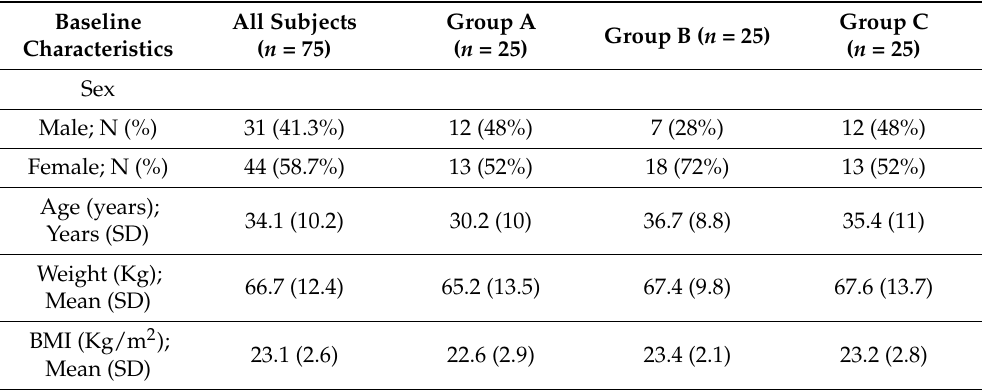
Table 1. Subjects demographic at baseline. No statistical differences were observed among groups. BMI = body mass index; SD = standard deviation.